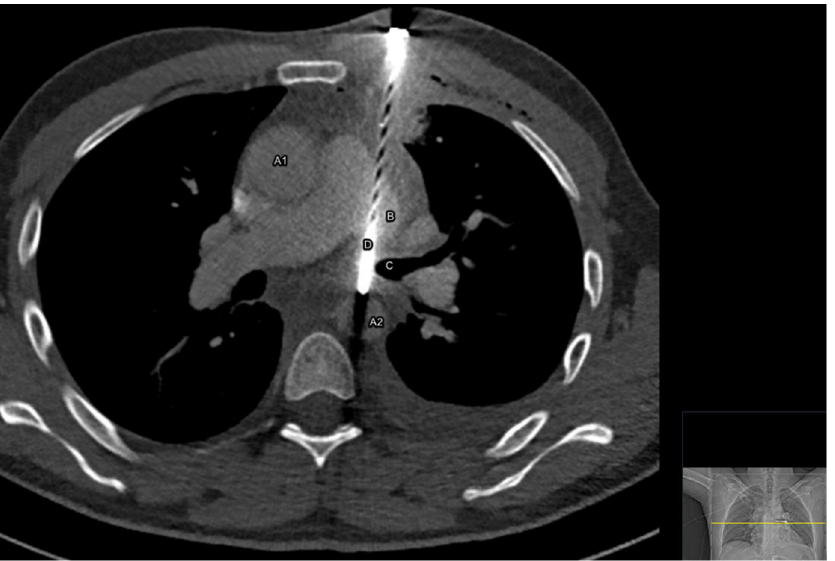
Figure 1. Transverse image of the chest CT scan showing a 12.6 cm long nail and its trajectory through the thorax and vital structures. A1 = ascending aorta, A2 = descending aorta, B = left pulmonary artery, C = left main bronchus, and D = nail (12.6 cm).